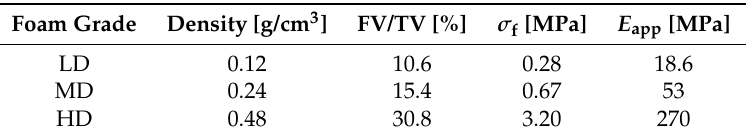
Figure 1. Specimens of different apparent densities analyzed in this work: High-density foam (HD) ( left ), medium-density foam (MD) ( center ) and low-density foam (LD) ( right ). Table 1. Mechanical and morphological properties provided by the manufacturer for each open-cell graded foam from